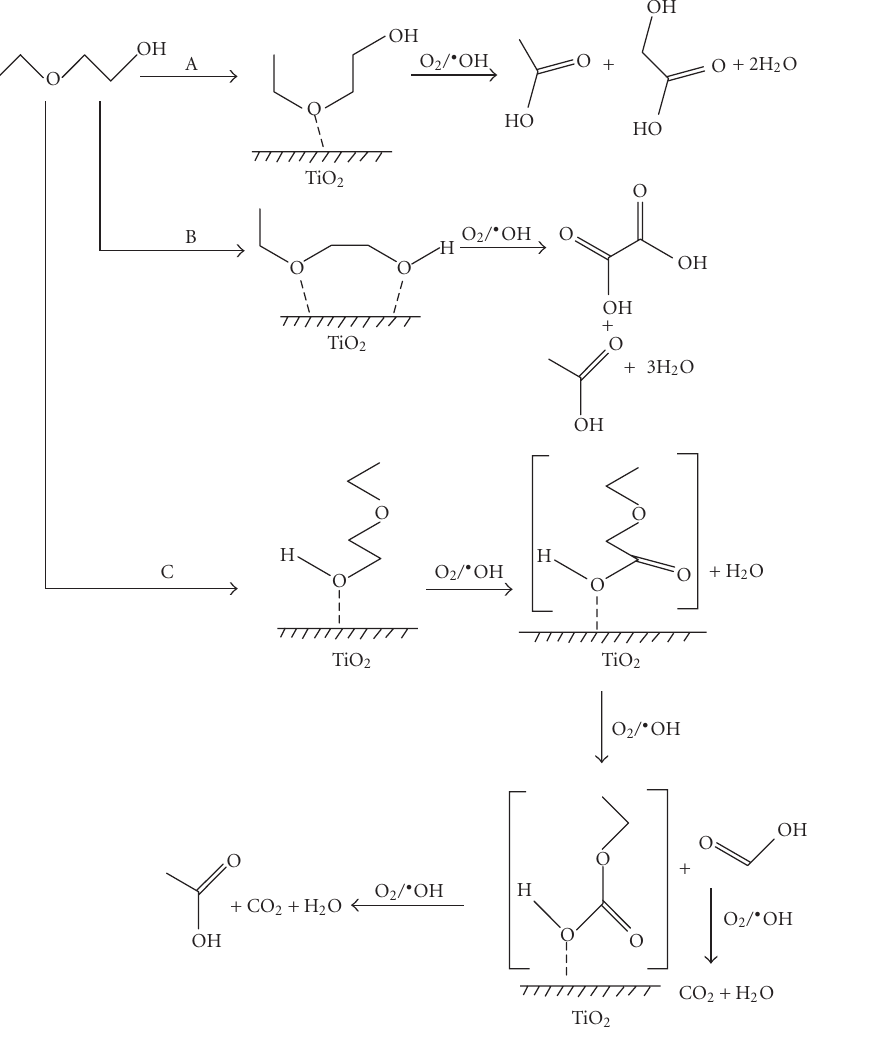
Figure 6: Outline of aqueous photocatalytic oxidation reaction of 2-ethoxy ethanol on TiO 2